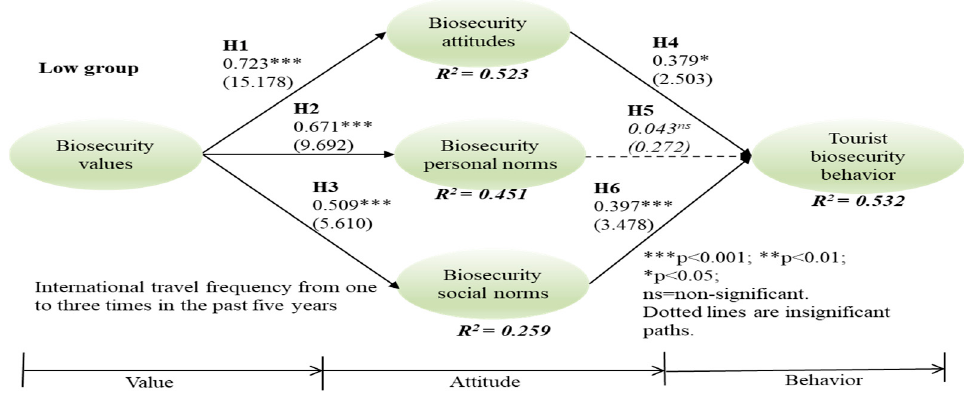
Figure 3. Low group of international travel frequency. *** p < 0.001; * p < 0.5; ns = non-significant.